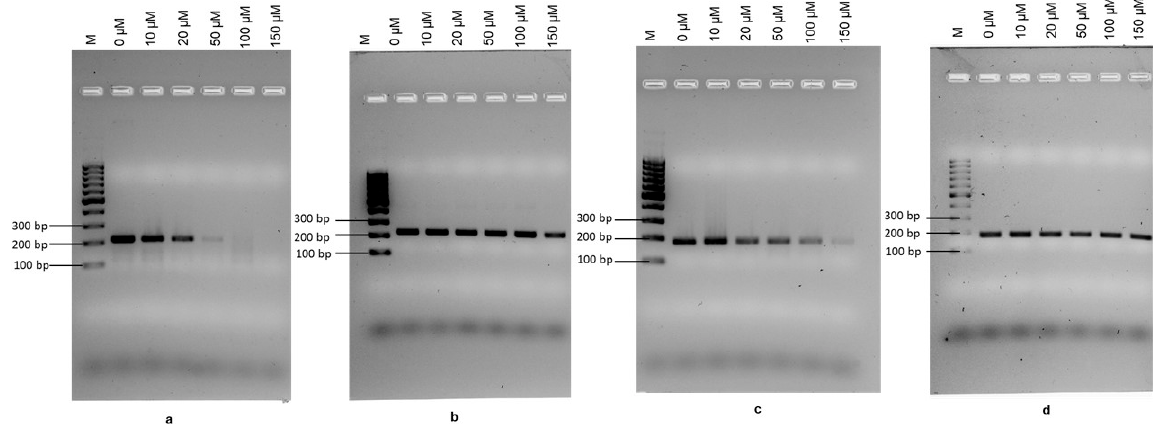
Figure 2. Optimisation of the PMAxx-recombinase polymerase assay (RPA). ( a – d ) PMAxx concentrations from 0 to 150 µ M; Lane M: molecular marker, Lane 2 to 7: RPA amplified DNA from E. coli O157:H7. ( a , b ) DNA amplified with the rfbE F1/R1 primer: ( a ) PMAxx treated dead cells, ( b ) PMAxx treated live cells. ( c , d ) DNA amplified with stx F1/R1 primer, ( c ) PMAxx treated dead cells, ( d ) PMAxx treated live cells.